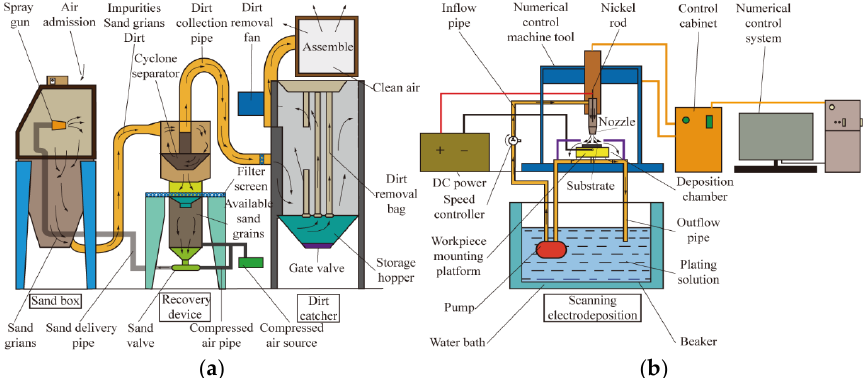
Figure 1. Schematic of the experimental procedure: ( a ) Sandblasting pretreatment device and ( b ) Scanning electrodeposition device.